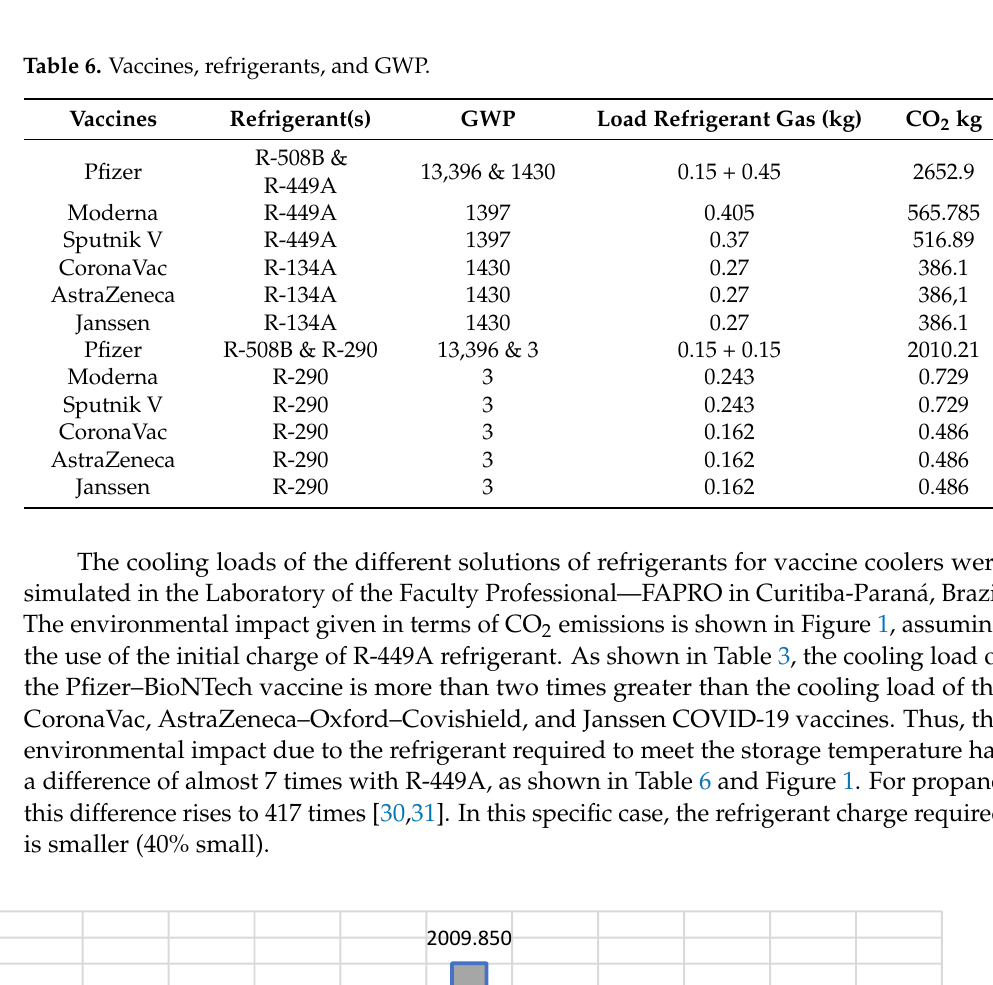
Figure 2. COP of refrigeration systems with evaporator and condenser fans for vaccines. 2.1. Vaccine Energy Usage Effectiveness Design (Vaccine EUED) Index Santos et al. [33–38] proposed the Energy Usage Effectiveness Design (EUED) index to measure the energy efficiency in data centers (DCs). A broader and more global view of energy consumption, emphasizing the environment, is given by this index [39–41]. The index provides an analysis involving all the natural parameters of the region where the system will be installed (dry and humid air bulb temperatures, soil temperature, and air